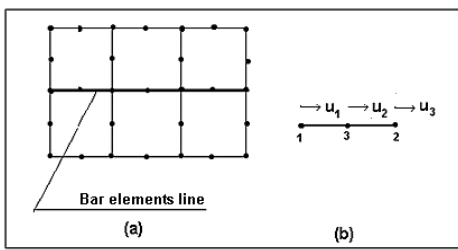
Figure 3. Finite elements: a) Plane Q8; b) bar